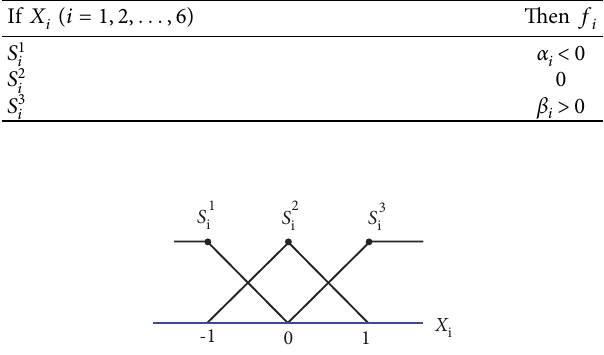
Figure 5: Membership functions related to FFSs of fuzzy system inputs for the cart-pole system.